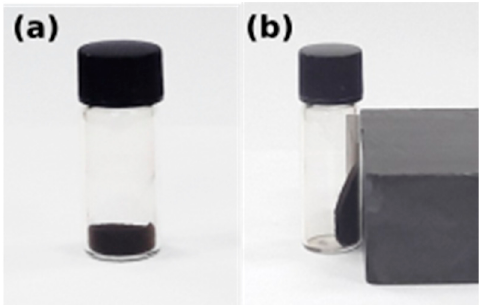
Figure 9. Iron oxide nanoparticles ( a ) without external magnetic field and ( b ) under external magnetic field.